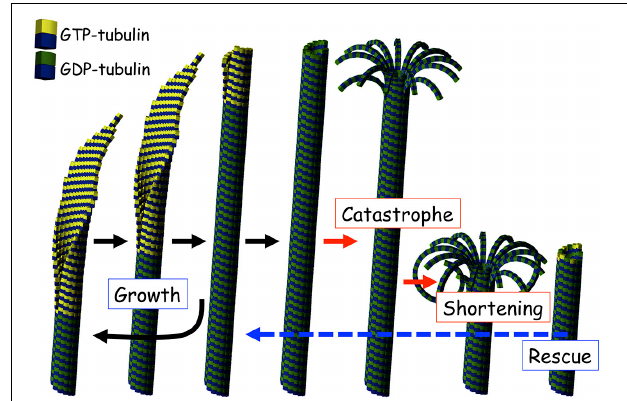
FIGURE 1 | Illustration of microtubule dynamics. A microtubule shows dynamic instability repeating growth and shortening. GTP-tubulin and GDP-tubulin were shown as colors of β -tubulin, yellow and green, respectively.